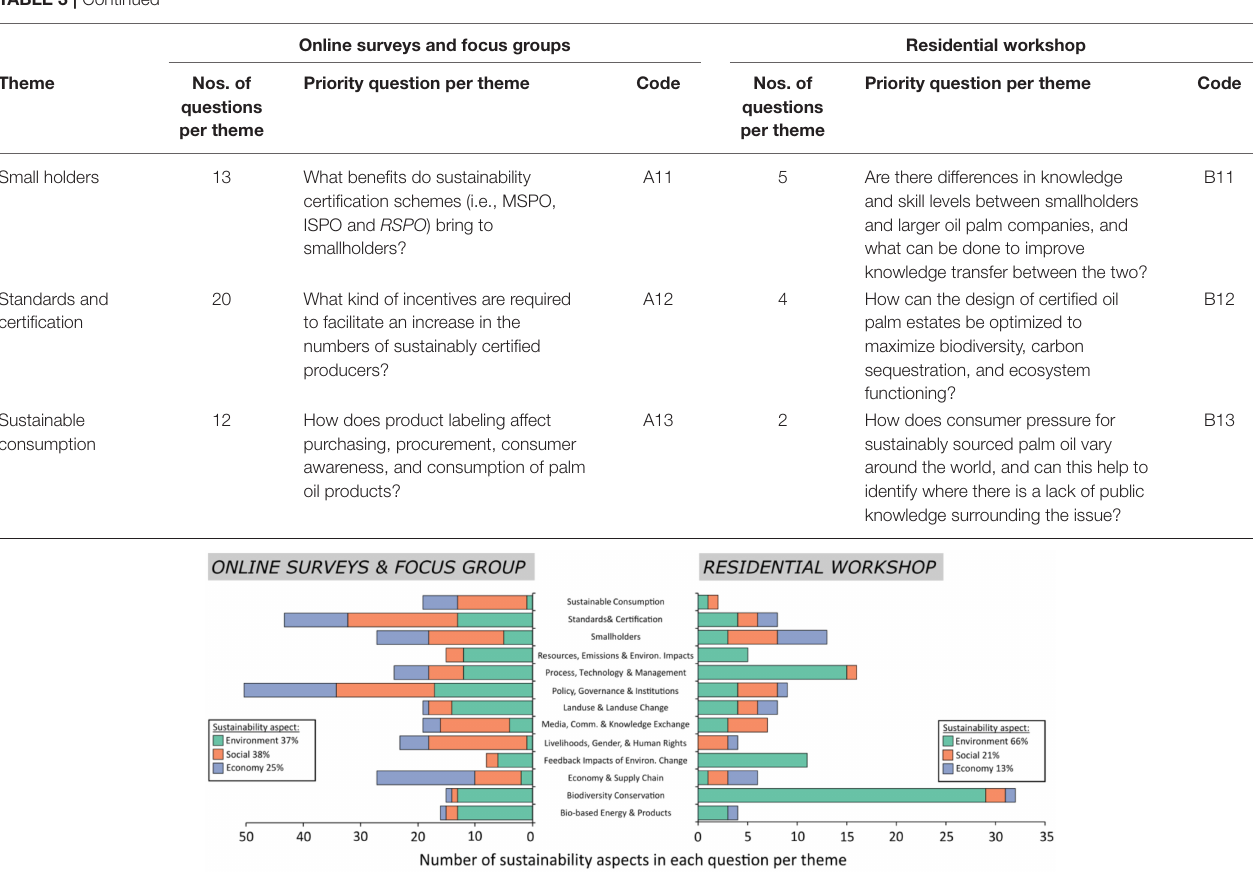
FIGURE 4 | Proportion of research questions as categorized by “sustainability aspect” in each theme. Research questions derived from the online surveys and focus groups are shown on the left and research questions derived from the residential workshop on the right. In the online surveys and focus groups the sustainability aspect as a proportion: Environmental (37%), Social (38%), and Economic (25%). In the residential workshop the sustainability aspect as a proportion: Environmental (66%), Social (21%), and Economic (13%). Individual questions could be assigned more than one sustainability aspect depending on its